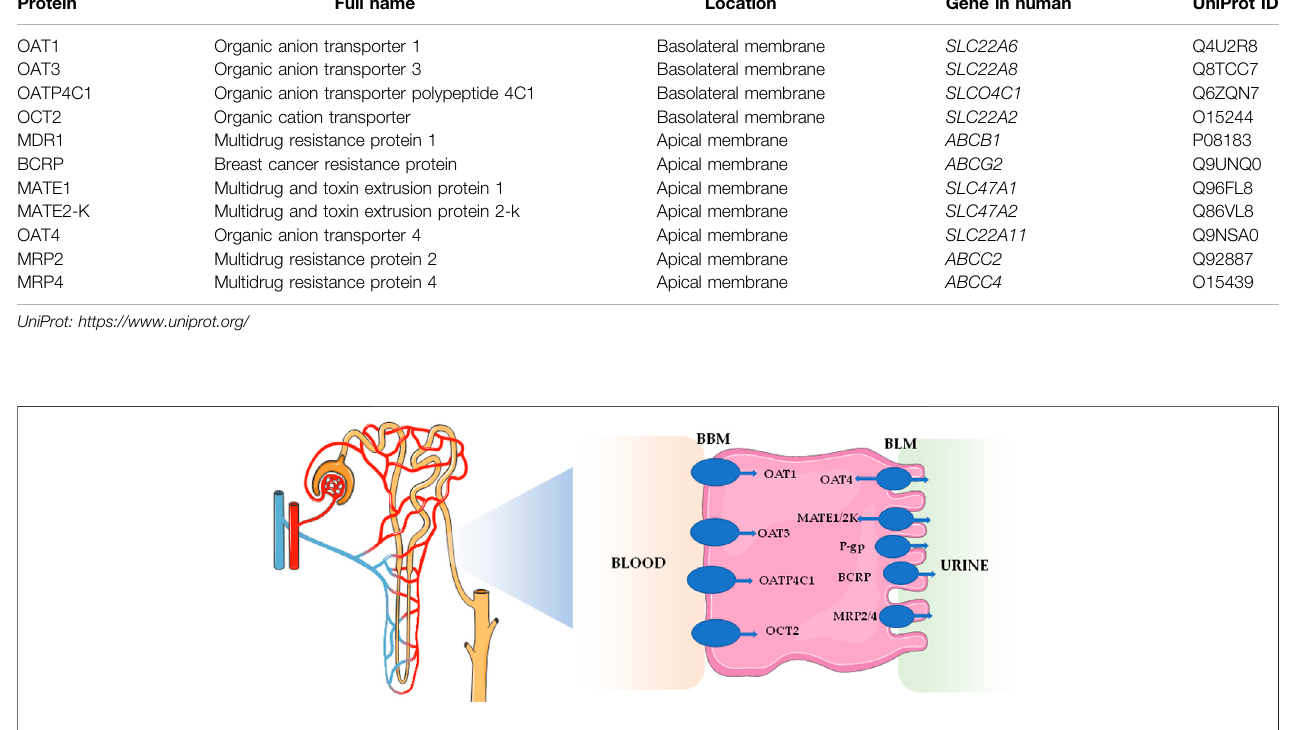
TABLE 1 | The main drug transporters on the proximal tubular cells. Protein